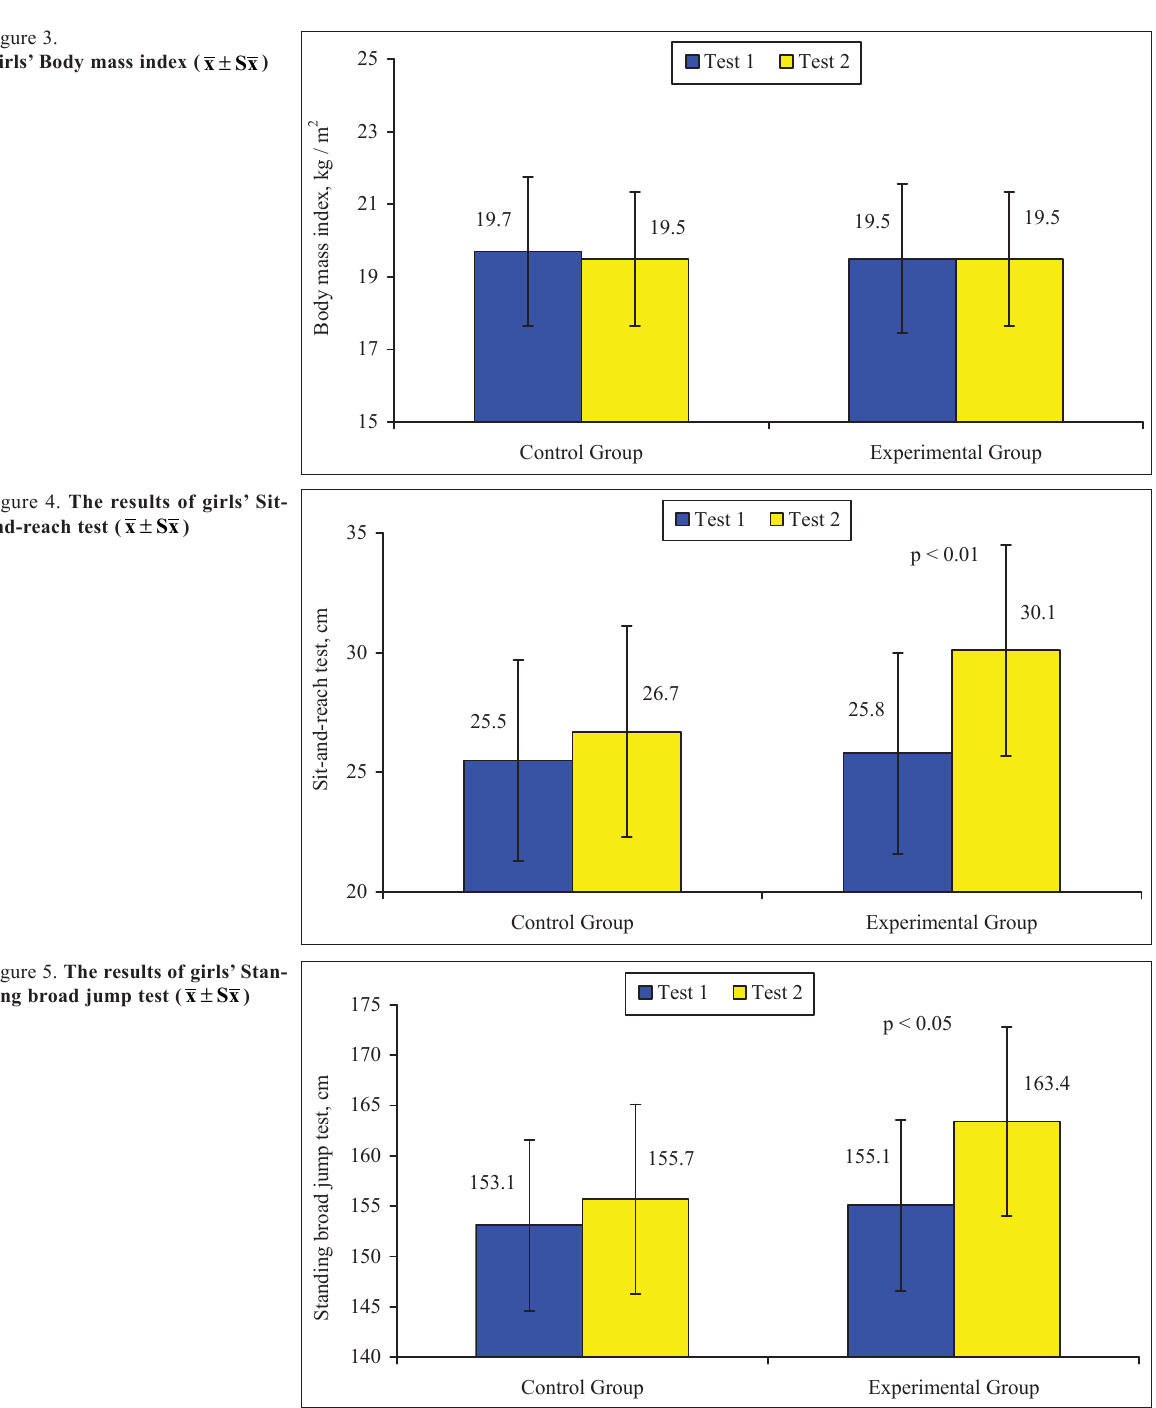
Figure 5. The results of girls’ Stan- ding broad jump test ( xSx